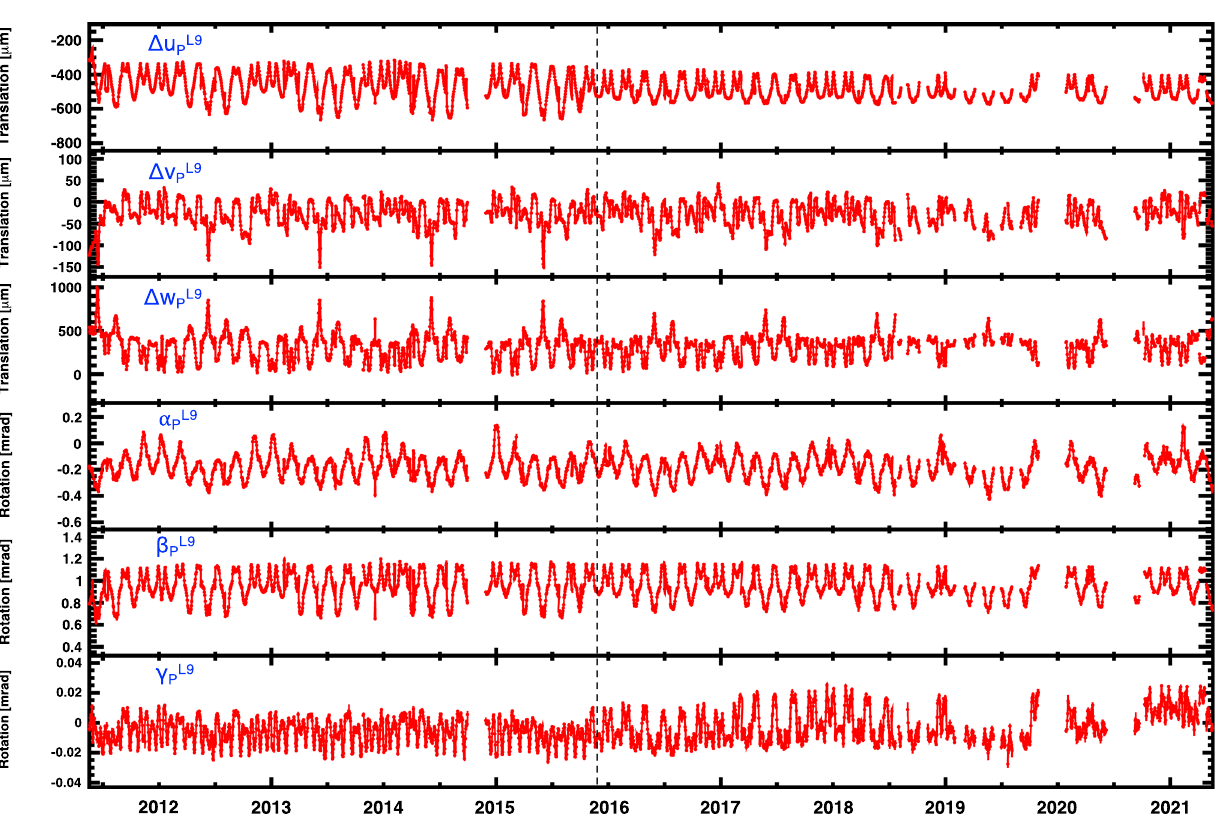
Fig. 17 The variations of the dynamic alignment parameters of L9 over 10 years from May 20, 2011 to May 20, 2021. Note the change in behavior starting from the end of 2015, which is due to the installation of a thermal blanket on the port ( − x ) side of AMS on Oct 28, 2015 (indicated by the vertical dashed line)